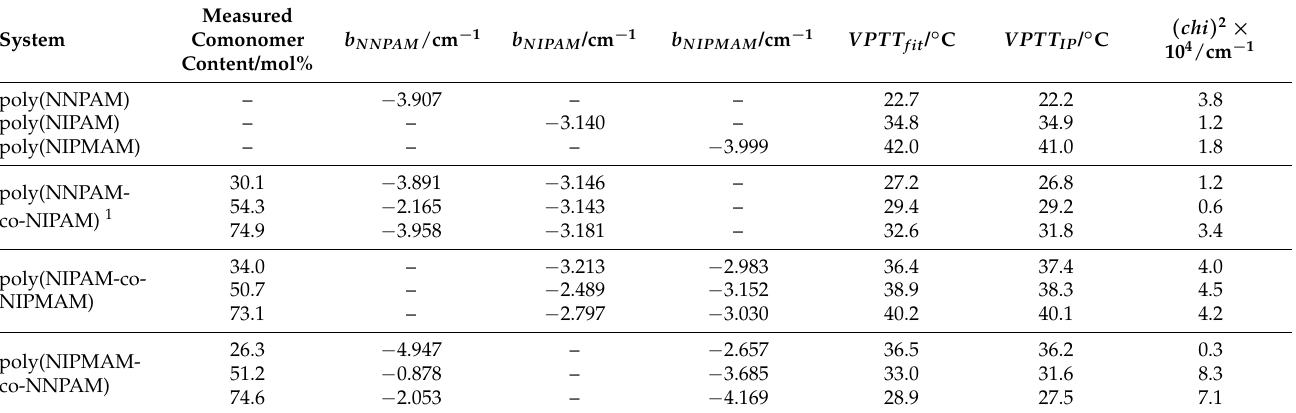
Table 3. Parameters resulting from the fit of ˜ ν max ( t ) -swelling curves and the corresponding ( chi ) 2 - values of the fits and the volume phase transition temperatures ( VPTT IP ) determined from the inflection point of the ˜ ν max ( t ) -swelling curves. The parameters a i were kept constant for the